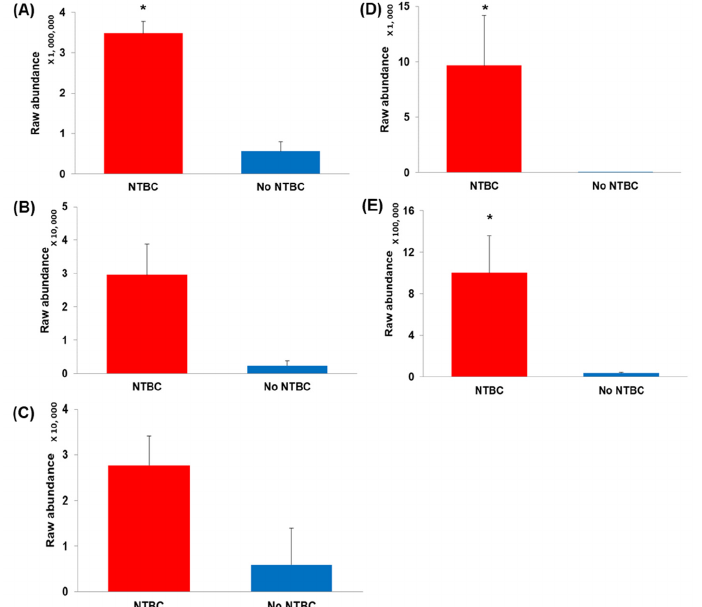
Figure 2. Bar graphs showing the mean raw abundances from LC-QTOF-MS analysis for metabolites that were matched to the AMRT database and had a log2 FC > 2.0. Error bars represent +1 standard deviation of the mean raw metabolite abundance ( A ) L-Tyrosine; ( B ) N-Acetyl-L-tyrosine; ( C ) γ‐ Glutamyl ‐ L ‐ tyrosine; ( D ) HPA; ( E ) HPLA. *—indicates significance, p < 0.05. NTBC—nitis ‐ inone. All data presented based on positive polarity ( n = 9 No NTBC, n = 8 NTBC) except ( E ) which is from negative polarity ( n = 9 No NTBC, n = 7 NTBC).